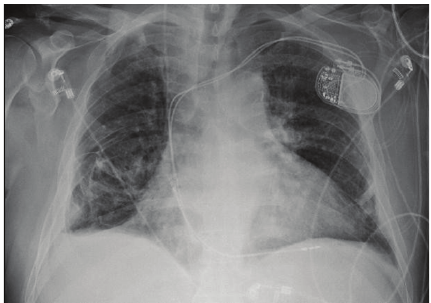
Figure 3: Follow-up chest X-ray showing improvement of lung